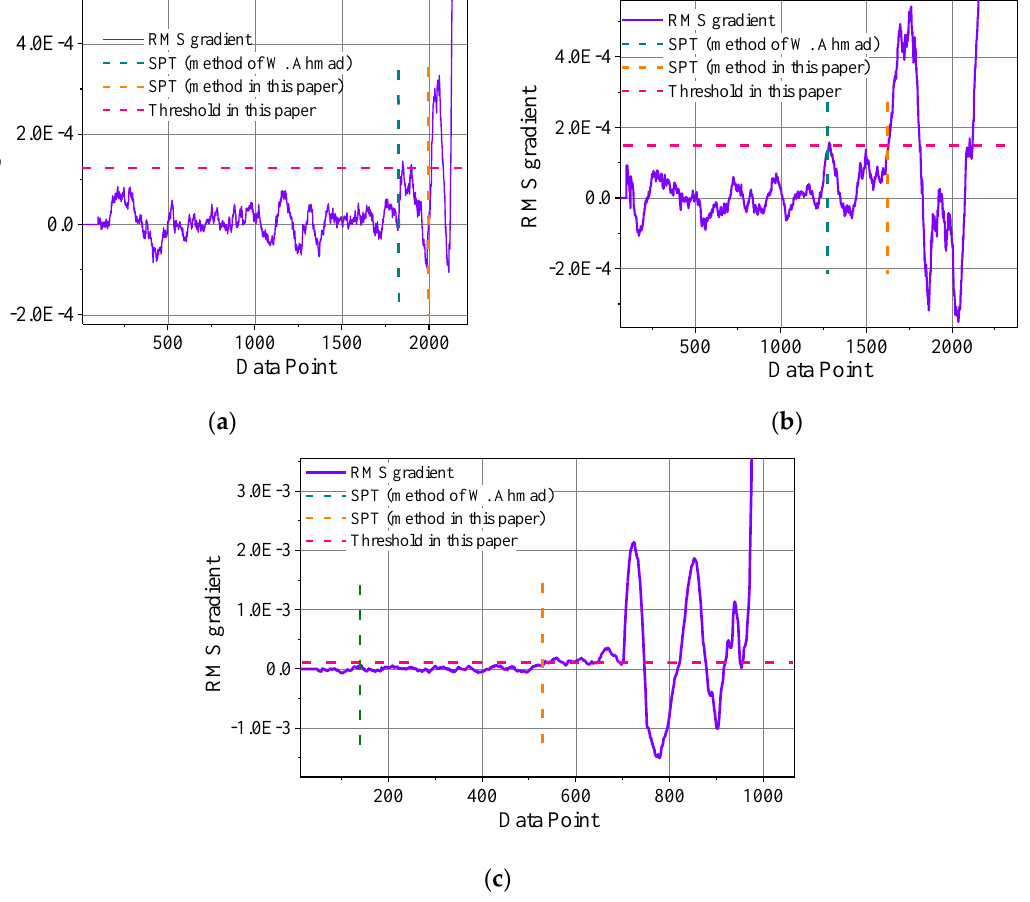
Figure 9. SPT under different methods: ( a ) Bearing 1, ( b ) Bearing 2, and ( c ) Bearing 3.